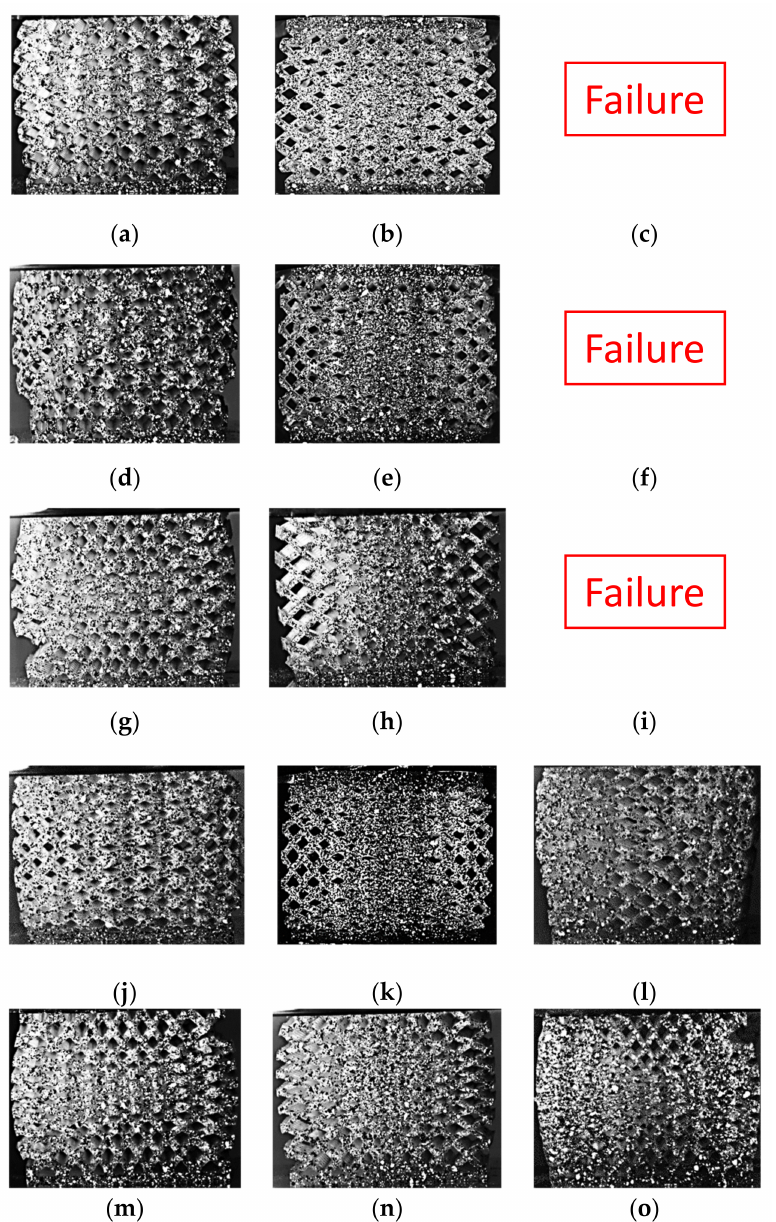
Figure 16. Deformation of the dual graded lattice designs at 30% compressive strain: ( a ) D1S1, ( b ) D2S1, ( c ) D3S1, ( d ) D1S2, ( e ) D2S2, ( f ) D3S2, ( g ) D1S3, ( h ) D2S3, ( i ) D3S3, ( j ) D1S4, ( k ) D2S4, ( l ) D3S4, ( m ) D1S5, ( n ) D2S5, and ( o )